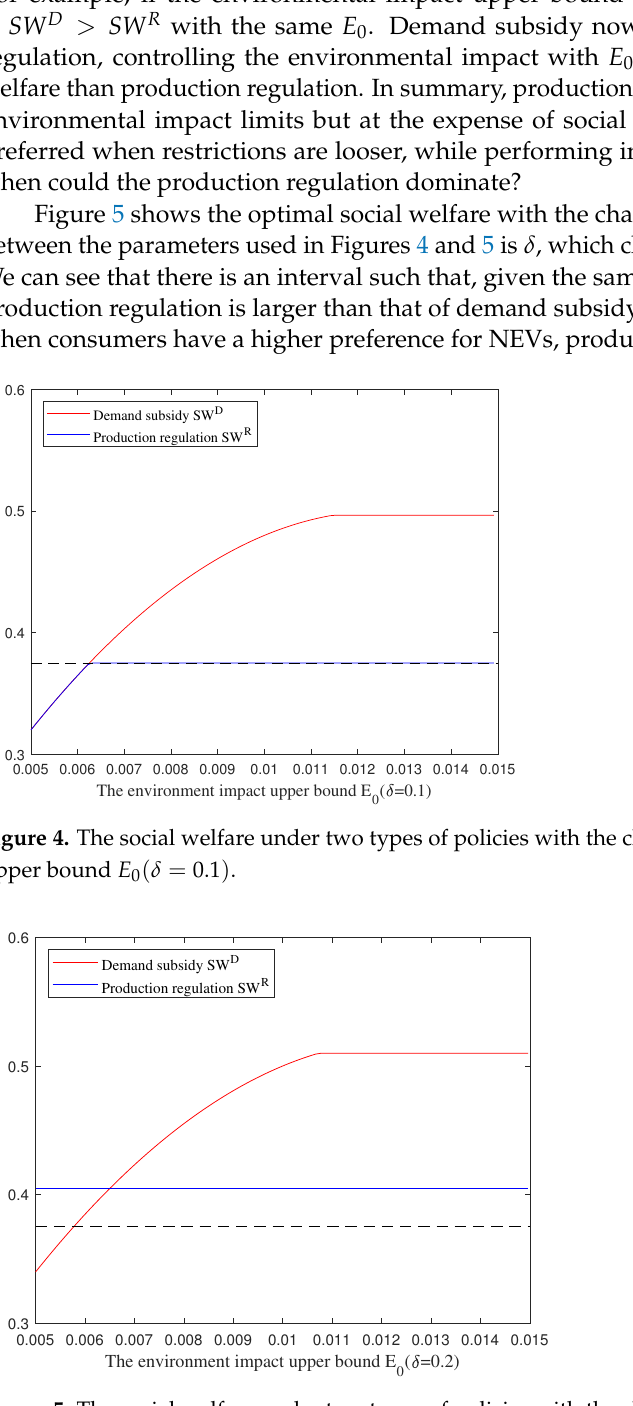
Figure 5. The social welfare under two types of policies with the change in the environment impact upper bound E 0 ( δ = 0.2 )